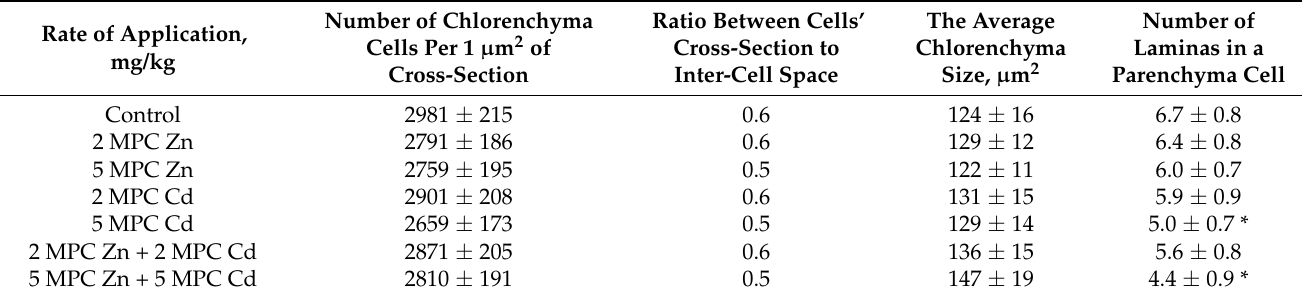
± —the standard deviation (SD); * significant at 0.050 probability